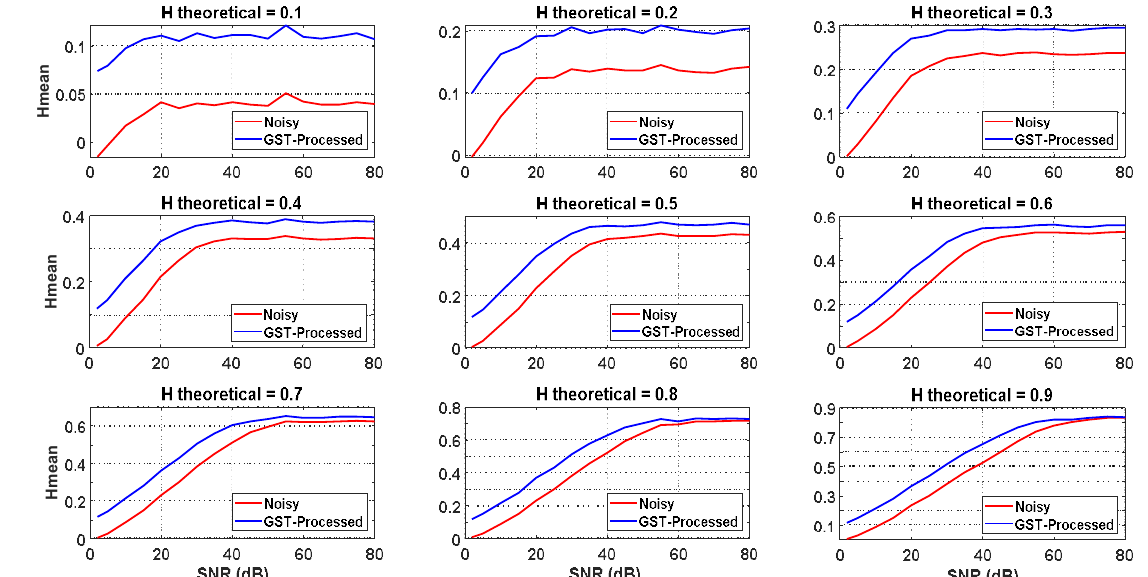
Figure 3. Estimated Hmean value versus SNR value at the nine fixed positions, obtained from noisy mBm paths (in red) and GST-processed mBm paths (in blue). The Hmean values are obtained by averaging H values at the fixed positions resulted from 1000 realizations of mBm paths.